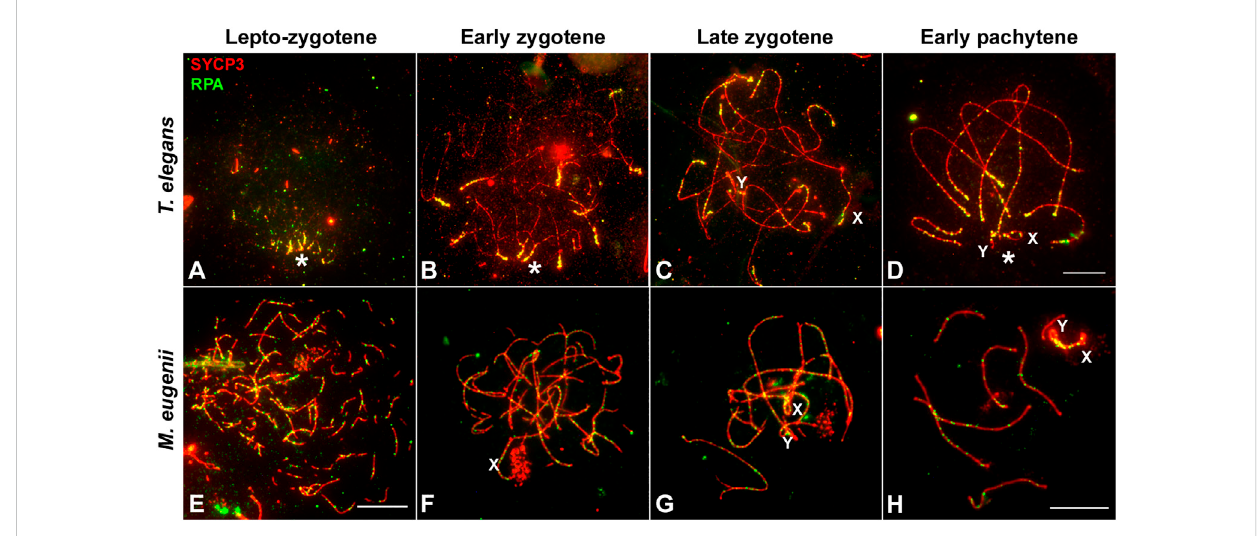
FIGURE 7 Localization of RPA. Spread spermatocytes labeled with antibodies against SYCP3 (red) and RPA (green). (A – D) . Thylamys elegans . Most RPA foci concentrate in the distal regions of autosomes from leptotene to pachytene. From late zygotene to pachytene, RPA foci also accumulate on the sex chromosomes (X, Y). Asterisk indicates the polarization of chromosomal ends. Sex chromosomes. (E – H) . Macropus eugenii . RPA foci associate to forming AEs at the leptotene to zygotene transition. From early zygotene onwards, foci are observed along theentire length of thebivalents. Bars in (A – D) and (E – H) : 10 μ m.